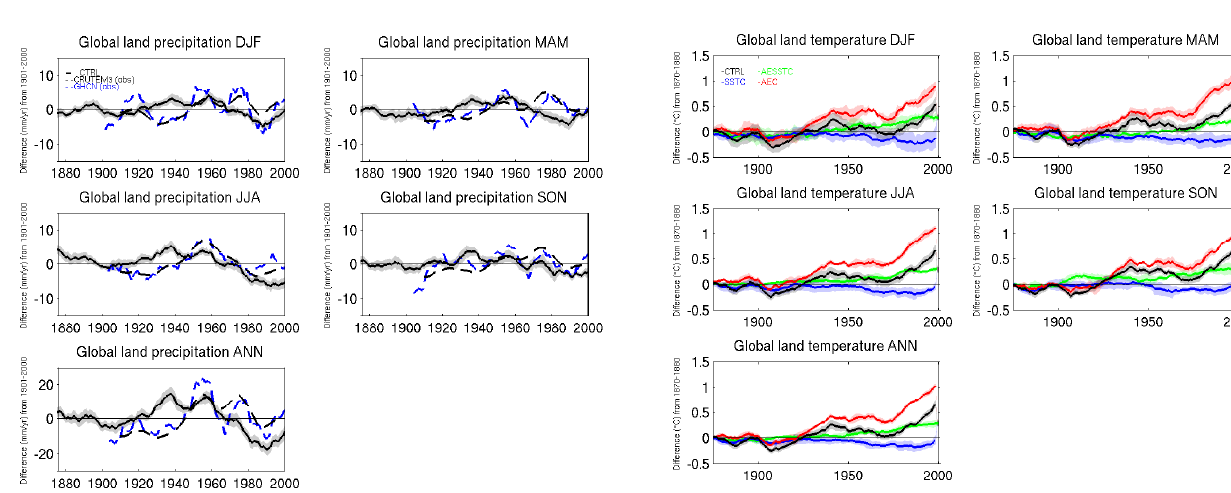
Fig. 4. Simulated (CTRL, solid) and observed (CRU, black dashed; GHCN, blue dashed) annual and seasonal global land precipitation anomalies (mmseason − 1 and mmyr − 1 , respectively), relative to the 1901–2000 mean, shown as 11yr running means. Gray shaded area corresponds to the ± 1 sigma spread of the ensemble CTRL.